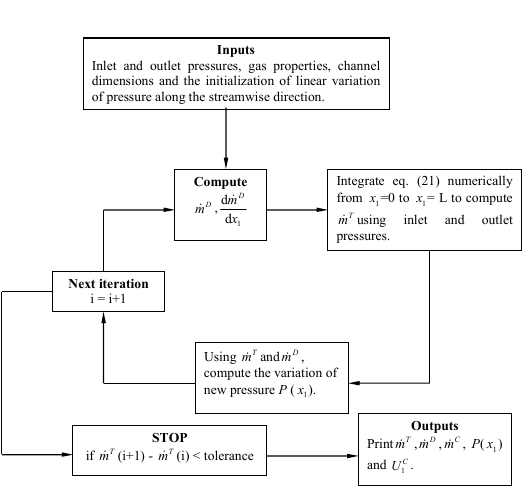
Fig. 2: Channel geometry, with the system of coordinates.